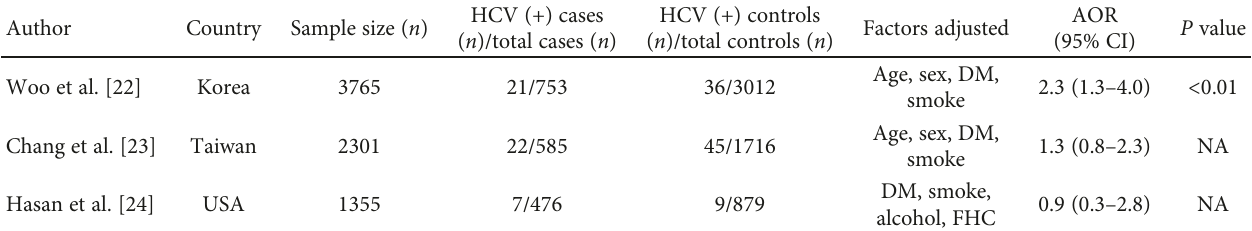
Table 1: Case-control studies for association of chronic HCV infection with pancreatic cancer